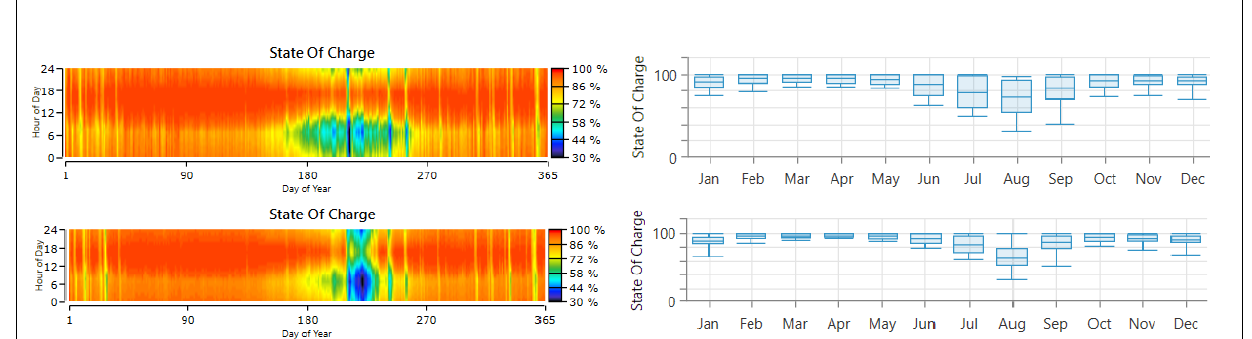
Figure 20. Battery State-of-Charge Case 1 ( upper ) and Case 2 ( bottom ) Scenario 3.